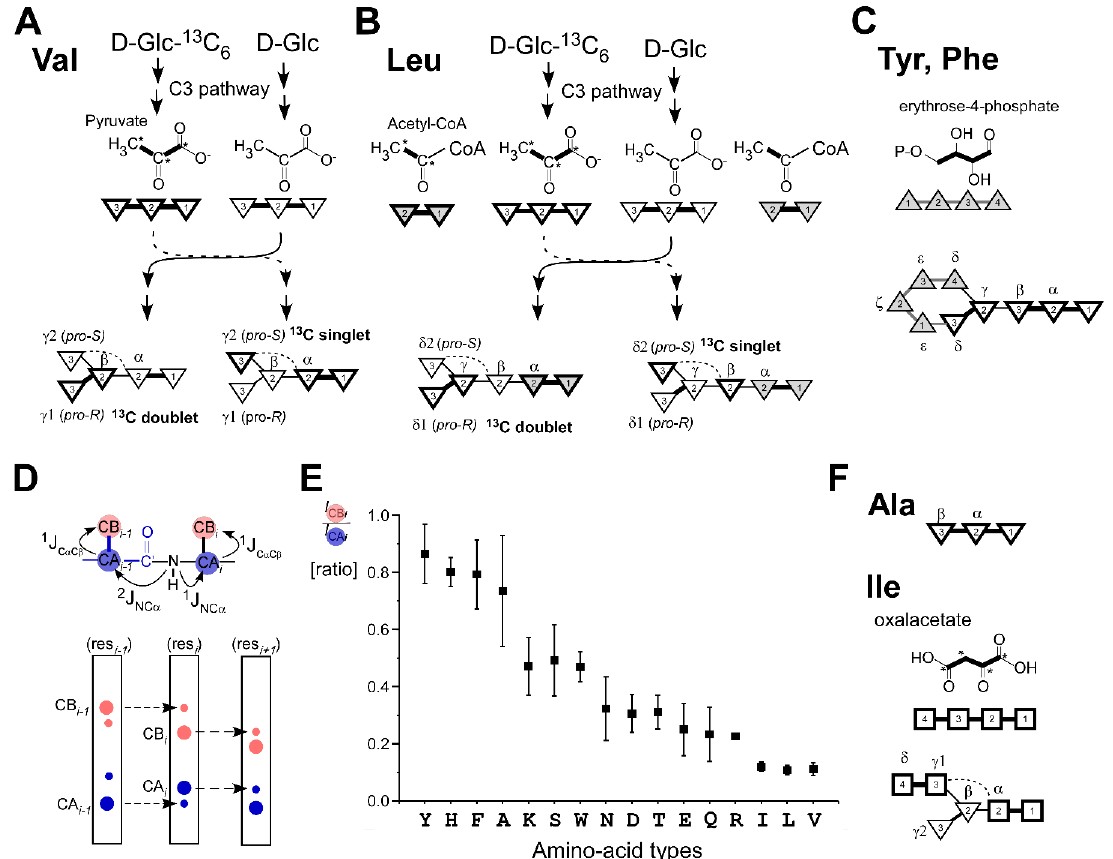
Figure 2. Effects of fractional 13 C labeling on NMR spectra. Schematic presentation of reaction pathways for the biosyn- thesis of valine (Val) ( A ) and leucine (Leu) ( B ) from a mixture of U- 13 C 6 glucose and unlabeled glucose, showing the stereochemistry [13]. Asterisks indicate 13 C atoms. 13 C-singlets and 13 C-doublets are indicated for pro-S and pro-R methyl groups in Val and Leu [13]. ( C ) Backbone skeletons of Tyr and Phe. The intermediate of erythrose-4-phosphate is shown and also presented schematically as four shaded triangles as carbon atoms connected with lines. Thick lines indicate the intact bond connection from glucose molecules. ( D ) J couplings used for sequential backbone assignments and sequential walks using strips from 3D spectra such as HNCACB, CBCANNH, and others. ( E ) A plot of the ratios of the intensities between C α and C β (CB i /CA i ) from HNCACB (SpaC) and intra-HNCACB (CBM64) against amino-acid types. Glycine (Gly) and proline (Pro) and the data with overlapped signals are removed from the analysis. In total, we used the following number of the data points for amino-acid types: Y (9), H (3), F (4), A (10), K(8), S(6), W(5), N (9), D (9), T (6), E (10), Q (8), R (1), I (7), L (10), and V (6), showing the amino-acid type in one-character codes with the number of data points in parentheses. ( F ) Backbone skeletons of Ala and Ile. Ala is biosynthesized via the pyruvate pathway. Ile is biosynthesized from oxaloacetate from the tricarboxylic acid (TCA) cycle [12]. Dashed lines indicate the fragment arising from the same intermediate molecule [12]. Inverse triangles indicate the carbon skeleton of the C3 unit of pyruvate intermediate from glycolysis [12]. The carbon skeletons of acetyl-CoA intermediates used for the biosynthesis of Leu are also shown in shaded inverse triangles. Open rectangles are carbon skeletons of the intermediate of the TCA cycle. Shaded triangles indicate the carbon skeleton from the pentose phosphate pathway. Thick lines indicate 13 C-labeled carbons or intact bonds from glucose. Greek alphabets show the positions in